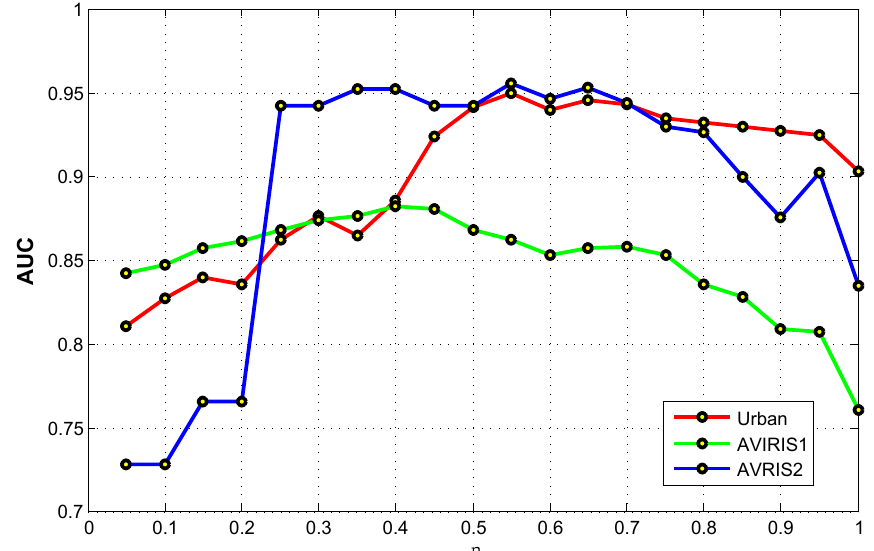
Figure 7. The effects of the feature selection ratio η of the proposed method on three hyperspectral images including Urban data set, AVIRIS1data set, and AVIRIS2 data